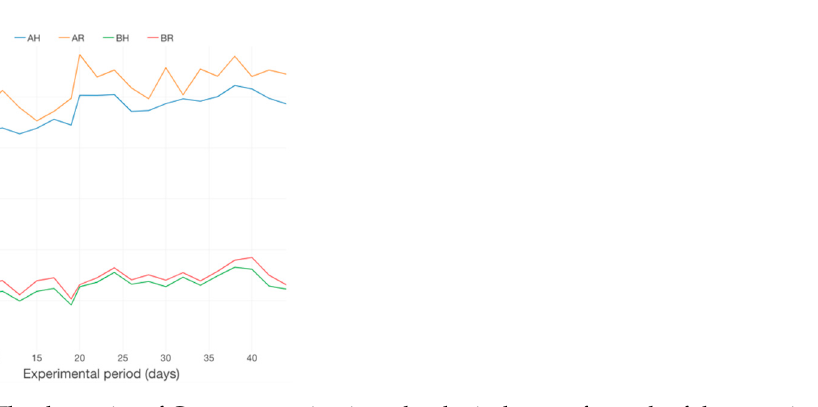
Figure 24. The dynamics of Mg concentration in technological water for each of the experimental variants. The nitrogen compounds reduction capacity is superior if conventional H GM is used, compared to R GM (Figure 25, Figure 26, Figure 27). Therefore, in the case of N- NH 4 , it can be observed a 20.75 ± 11.10% reduction in AH experimental variant, compared to 19.58 ± 9.47% in AR, while in BH a 26.53 ± 12.62% N-NH 4 reduction is recorded, com- pared to 18.95 ± 12.88% in BR (Figure 25). Statistically significant differences ( p < 0.05) were recorded between BH and the rest of the experimental variants. The results reveal that the H GM performed better in both technological scenarios (A and B), compared to R GM. However, the R GM assures similar N-NH 4 reduction in both tested technological